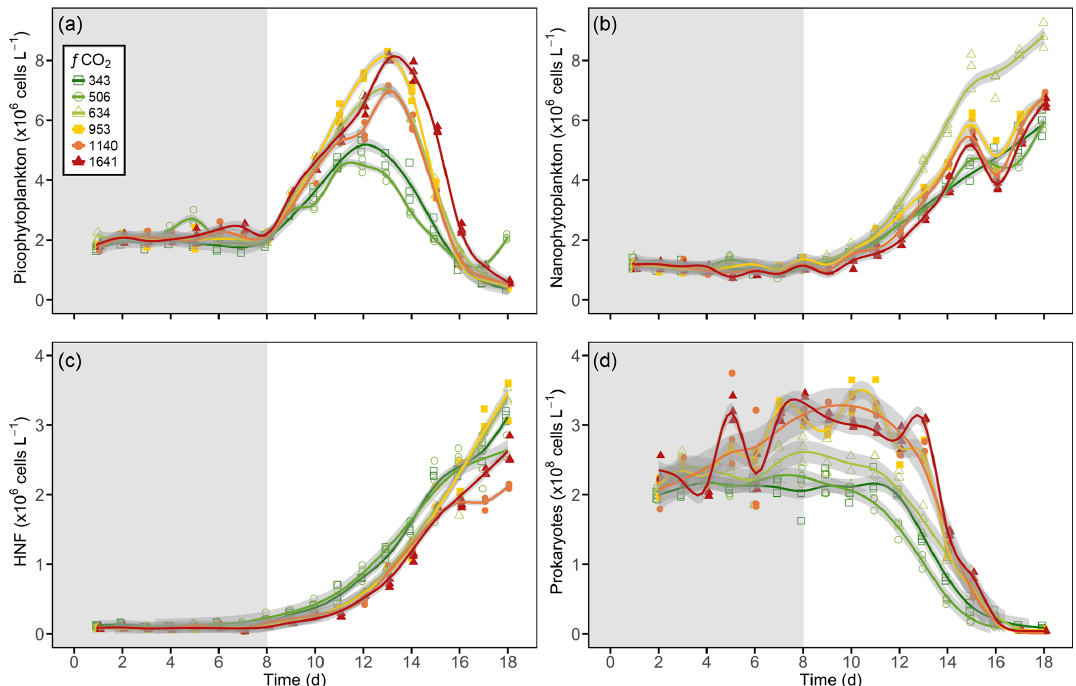
Figure 6. Generalised additive model fits for (a) picophytoplankton, (b) nanophytoplankton, (c) heterotrophic nanoflagellates (HNFs), and (d) prokaryotes in each of the minicosm treatments over time. Shading above and below fitted lines (grey) displays the 95% confidence interval for model predictions. Grey shading on the plot background indicates CO 2 and light acclimation